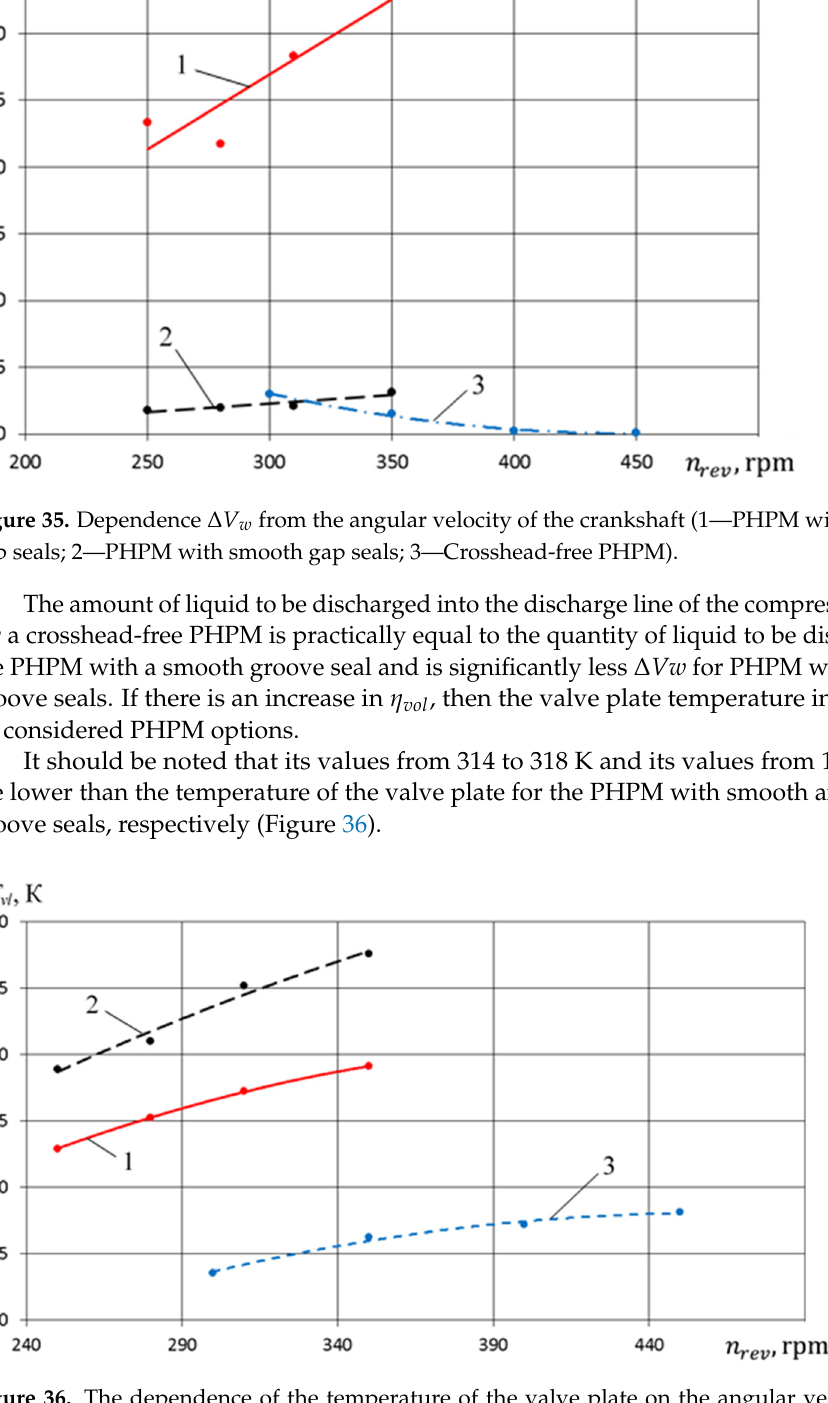
Figure 36. The dependence of the temperature of the valve plate on the angular velocity of the crankshaft (1—PHPM with step-type gap seals; 2—PHPM with a smooth gap seal; 3—Crosshead- free PHPM).